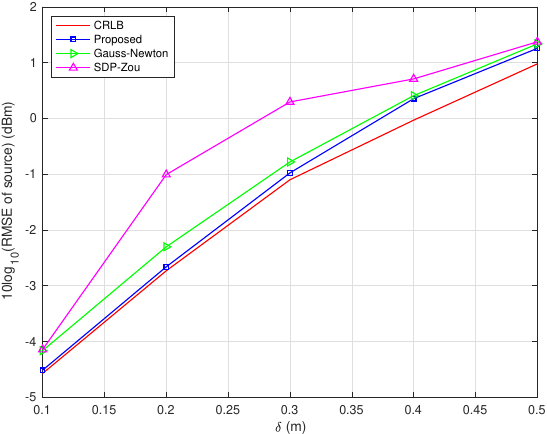
Figure 2. RMSE of source vs. δ with σ = 0.1 m in scenario 2.